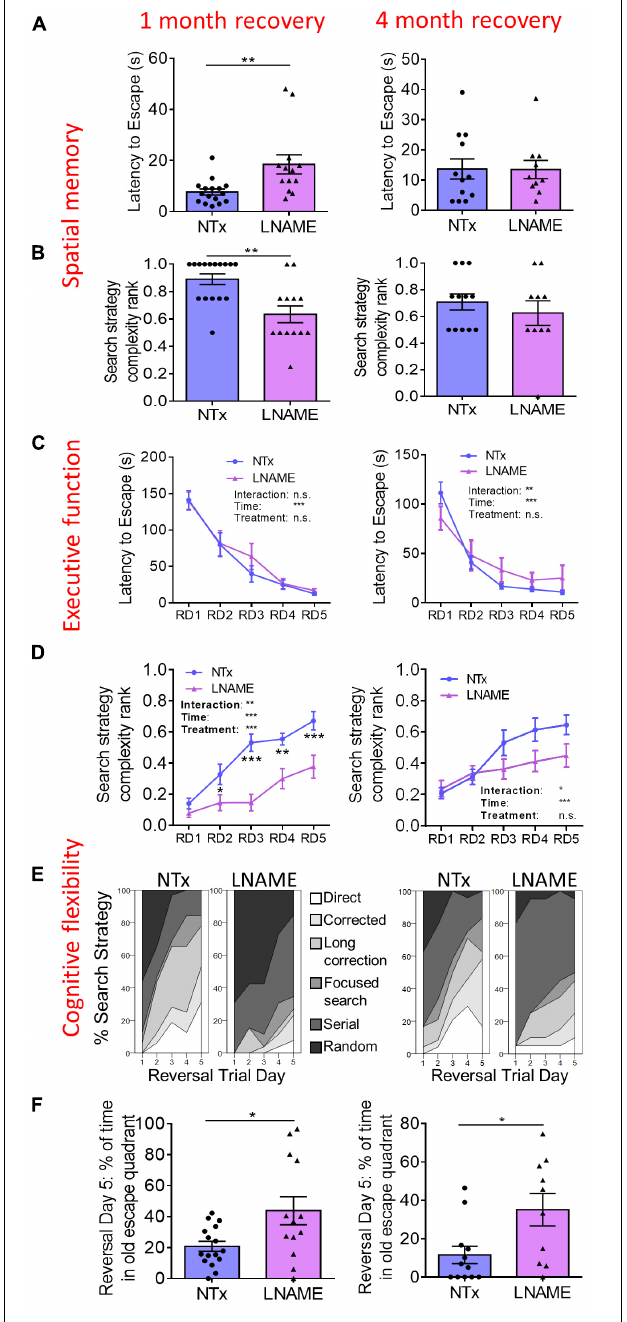
FIGURE 2 | Cognitive functions are impaired in rats 1 month after transient hypertension and are partially restored after 4 months. (A,B) In the probe trials, hypertension increased latency to escape ( p = 0.006) and decreased search strategy complexity ( p = 0.003) 1 month after normotensive recovery (left) demonstrating deficits in spatial memory. Four months after normotensive recovery (right), these deficits were no longer present ( p = 0.971 for latency to escape, p = 0.631 for search strategy complexity). (C) In the reversal trials, hypertension did not affect executive function at both 1 month ( p = 0.631) and 4 months ( p = 0.692) recovery as two way repeated measures ANOVA did not show a treatment effect. (D) In the reversal trials, hypertension decreased